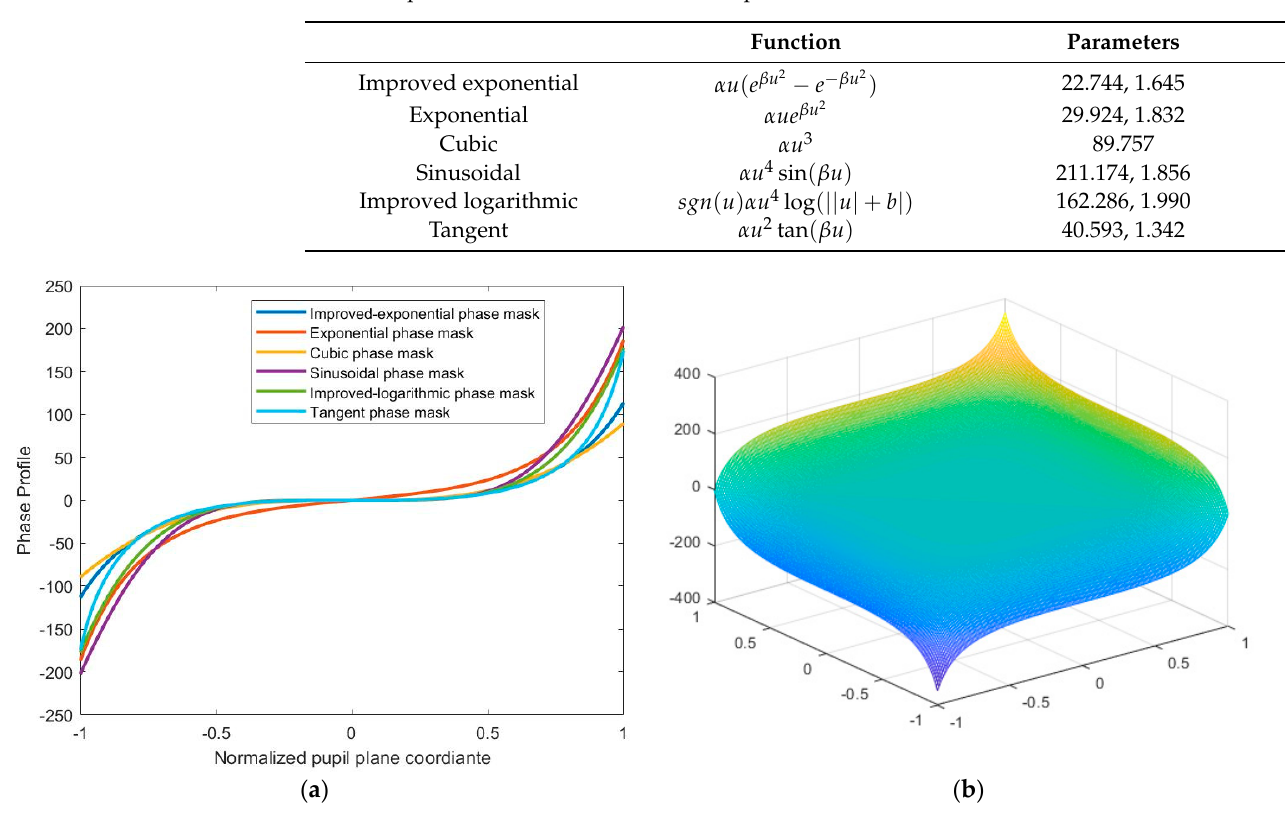
Table 1. Optimization results of six kinds of phase masks.